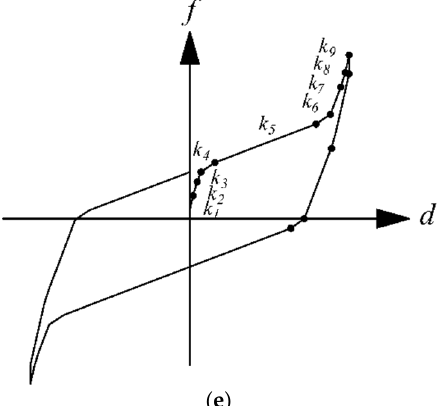
Figure 7. Idealized force-displacement relationship for various isolators. ( a ) P-F isolator, ( b ) FP isolator, ( c ) double concave friction bearing, ( d ) triple pendulum bearing, ( e ) quintuple friction pendulum isolator.